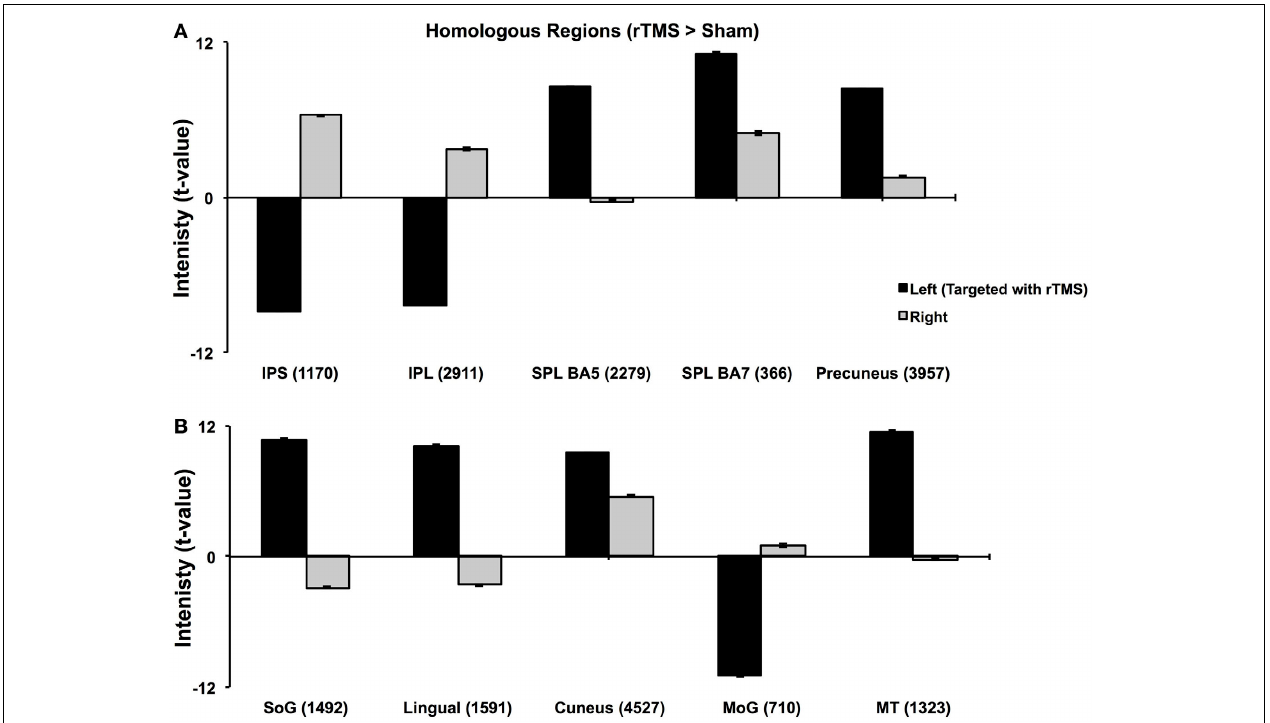
FIGURE 3 | Analysis of Homologous ROIs. Quantitative comparison of t -values of intensities of homologous ROIs. For homologous ROIs of comparable size (number of voxels noted in parentheses), t -values of intensity on left (targeted hemisphere) are compared with those of their homologues on right. (A) Comparison of homologous voxels pairs in